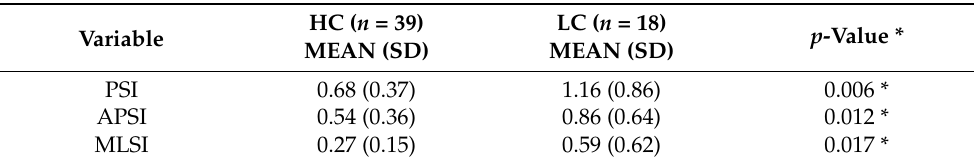
Table 5. Postural stability variables of LC and